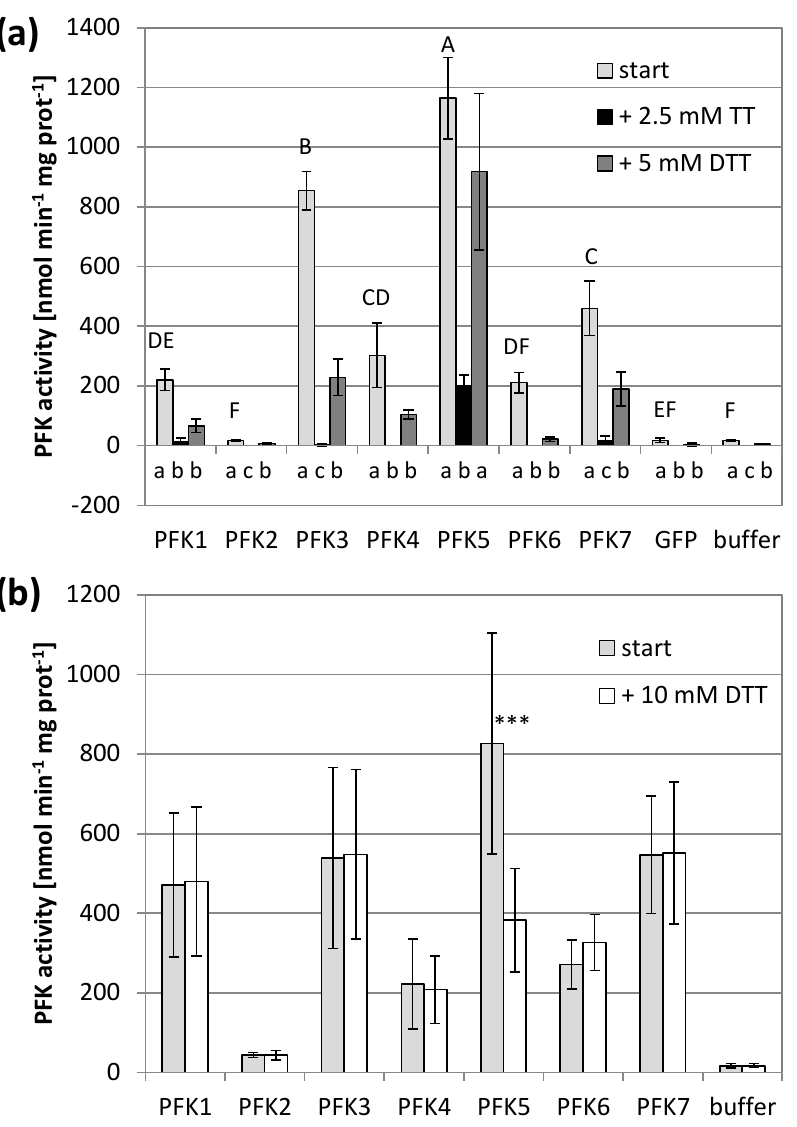
Figure 2. Redox sensitivity of Arabidopsis thaliana PFKs. ( a ) A. thaliana PFKs were transiently overexpressed in tobacco leaves. Leaves were extracted with buffer containing 5 mM β -mercaptoethanol ( β -ME). After determining the initial activity, samples were oxidized with 2.5 mM sodium tetrathionate (TT) for 20 min and afterwards re-reduced with 5 mM dithiothreitol (DTT). The results are means ± SD of n = 3. Upper case letters show significant differences for each isoform to buffer and GFP control ( p < 0.05, ANOVA and Post hoc Tukey test), lower case letters indicate significant differences among treatments for each protein isoform at p < 0.05 (ANOVA, Post hoc Tukey test). ( b ) A. thaliana PFK1-7 were transiently overexpressed in tobacco leaves and extracted with 5 mM β -ME and additionally reduced under partially denaturing conditions with 10 mM DTT, 175 mM Bis-Tris propane (pH 9.0) and 500 mM NaCl. The results are means ± SD of n = 10. The asterisks (***) indicate a significant difference to untreated control at p < 0.05 ( t -Test).